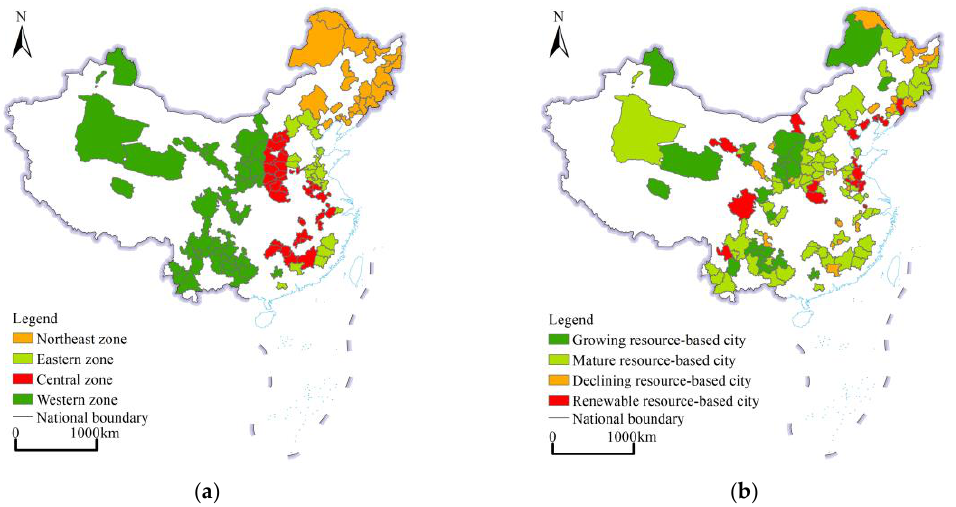
Figure 1. Classification and distribution of RBCs in China. ( a ) Classification of RBCs by region; ( b ) classification of RBCs by development stage.